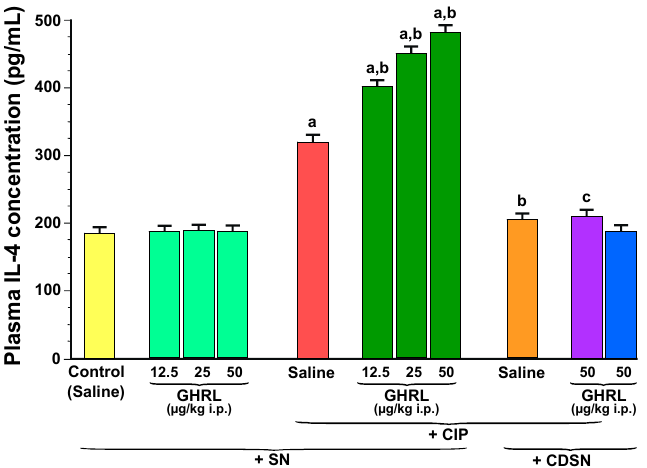
Figure 7. Effect of saline or ghrelin (GHRL) given intraperitoneally at a dose of 12.5, 25 or 50 μ g/kg and cerulein-induced pancreatitis (CIP) on plasma concentration of interleukin-4 (IL-4) in sensory nerves-intact rats (SN) or rats with capsaicin deactivation of sensory nerves (CDSN). a p < 0.05 compared to the control group with intact sensory nerves and without induction of CIP; b p < 0.05 compared to sensory nerves-intact rats with CIP pretreated with saline; c p < 0.05 compared to sensory nerves-intact rats pretreated with GHRL at a dose of 50 μ g/kg prior to CIP. Mean ± SEM from values obtained from 10–15 rats in each experimental group.